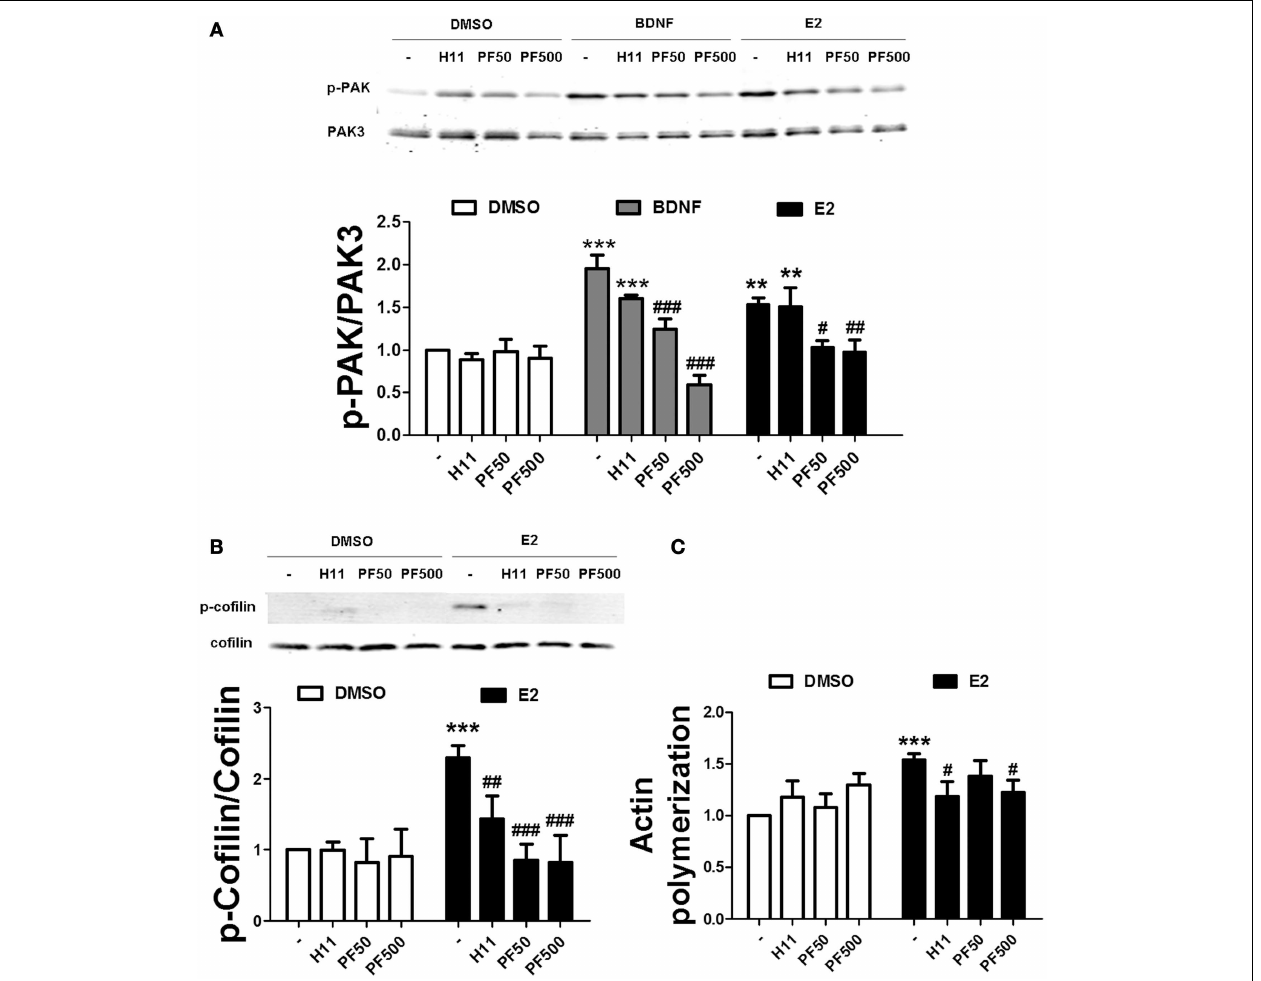
cofilin ( N = 3–10). (C) Treatments were performed as described above (for E2 the incubation time was 60min) and slices were fixed, homogenized and labeled with Phalloidin-TRITC (15–30nM). Data are presented as fluorescence values (fold of control) and are means ± SEM of four to eight independent experiments; ** p < 0.01, *** p < 0.001, as compared to control (DMSO); ## p < 0.01, ### p < 0.001, as compared to E2 or BDNF alone (two-way